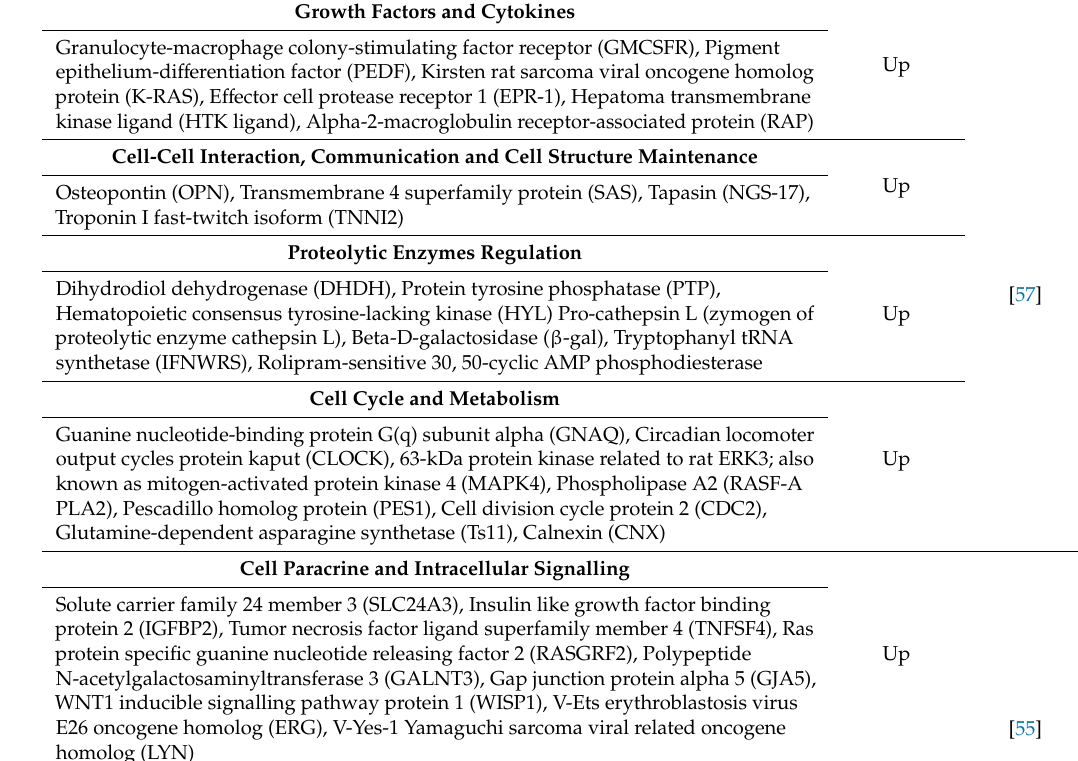
Table 2. Alteration of gene and protein expressions upon acquisition of BCAF phenotype from breast